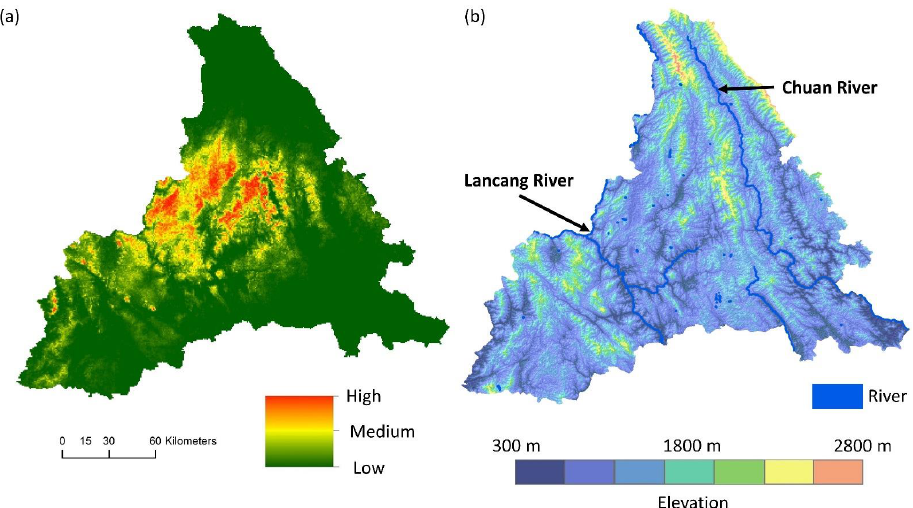
Figure 3. Suitable areas of ancient Pu’er tea trees ( a ). High values indicate high probabilities (logistic output) of plant occurrence, and we categorized them into three classes (high, medium, and low) for better understanding. The elevation map ( b ) with the two main rivers marked is shown to aid visualization of the potential habitat of ancient tea trees across different elevations and rivers.